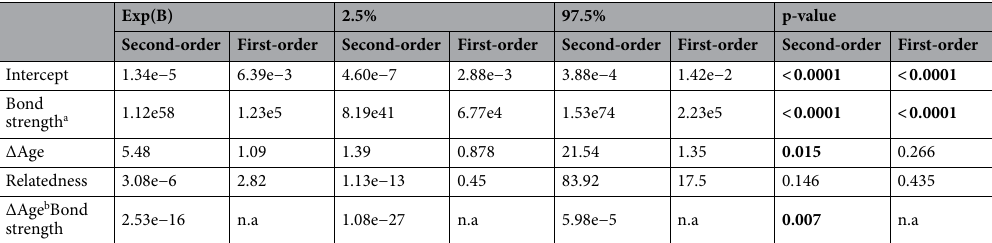
Table 1. Results from the GLMMs investigating second-order alliance member choice and first-order partner preferences. Exponentiated fixed effects (Exp(B)) representing odds ratios, lower and upper confidence bounds (2.5% and 97.5%) and p -values of second-order GLMM and first-order GLMM investigating the effect of pairwise relatedness, age similarity, and SRI on choices of first-order partners and second-order members. a SRI during the focal male’s adolescence for the model concerning second-order alliances, non-mating season SRI between males for first-order alliance partner choice. Age b Bond strength denotes the interaction term between age difference and adolescence social bond strength on the level of second-order alliance member choice. Values in bold denote statistical significance ( p < 0.05).